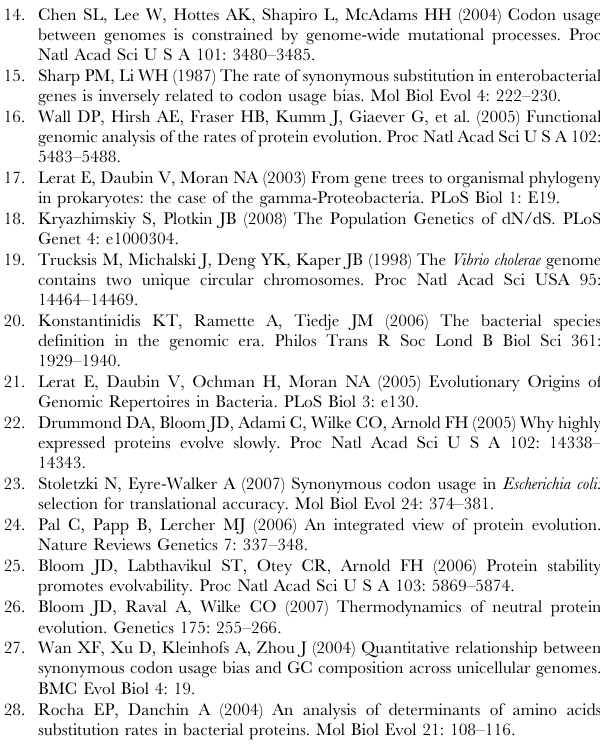
Table S7 Different measures of codon usage bias and predicted expression among genes on different chromosomes (c1-c3).